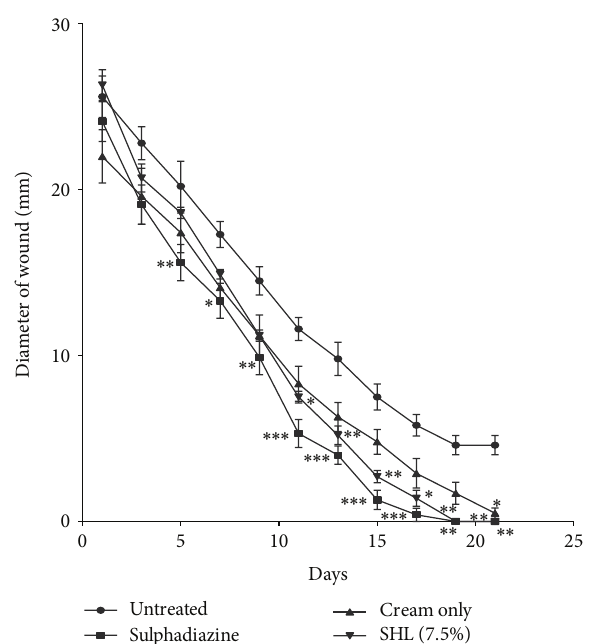
Figure 8: Influence of methanol leaf extract (SHL) cream (7.5% w/w) of S. hispidus on the rate of closure of wounds. Values are diameter of wounds expressed as mean ± SEM ( 𝑁 = 5 ). ∗ 𝑃 < 0.05 , ∗∗ 𝑃 < 0.01 , and ∗∗∗ 𝑃 < 0.001 . Control is the untreated wounds. 1% w/w silver sulphadiazine was used as positive control.